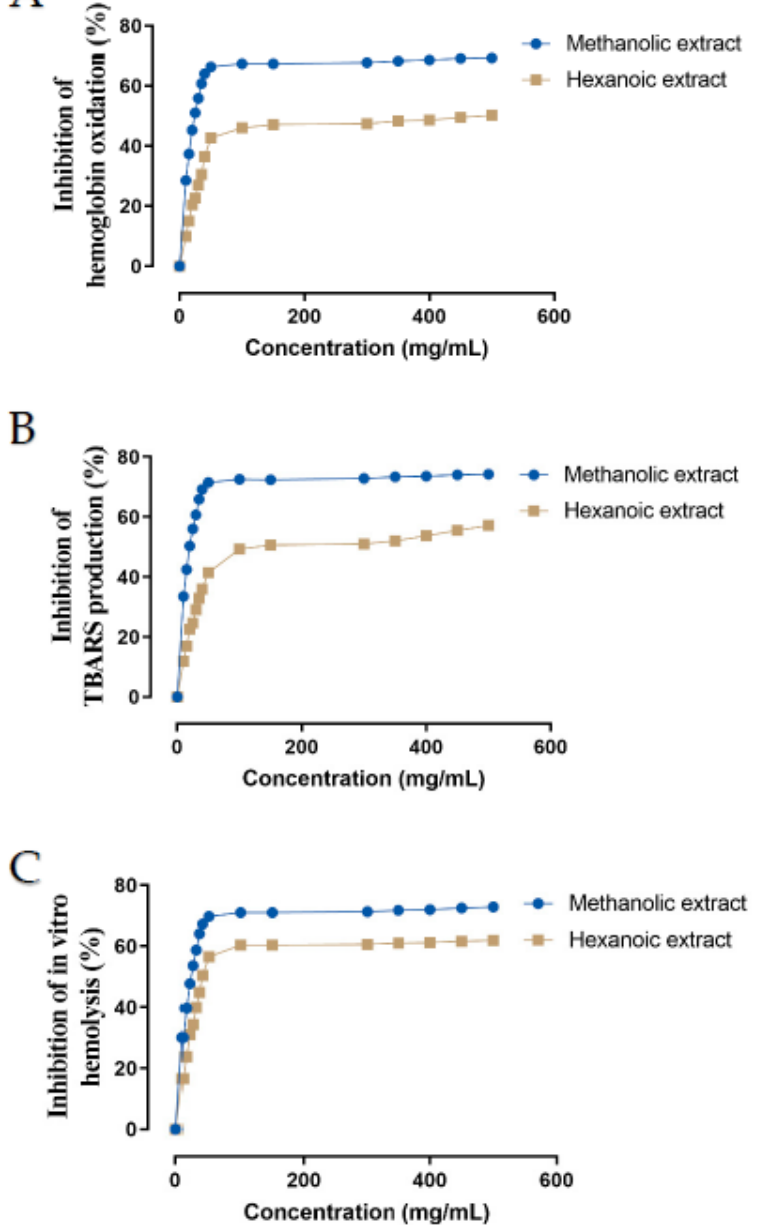
Figure 3. Effect of methanolic and hexanoic extracts of Farang ( P. guajava L.) leaves against ( A ) hemoglobin oxidation, ( B ) lipid peroxidation, ( C ) hemolysis.